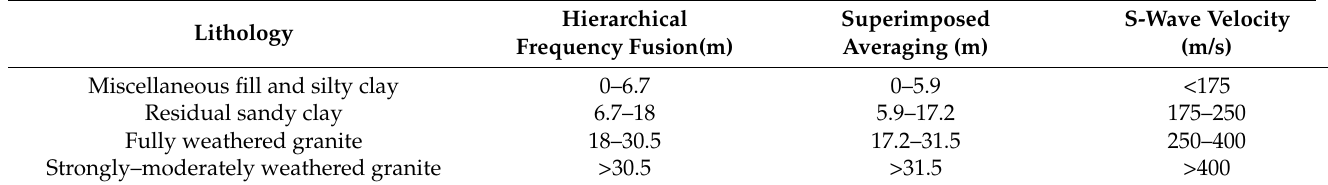
Table 2. Stratigraphic delineation results of two